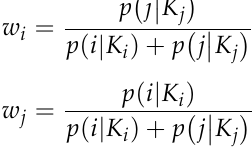
Figure 4. NDVI profile at point (93.8182° E, 27.7992° N) from 1986 to 2022.